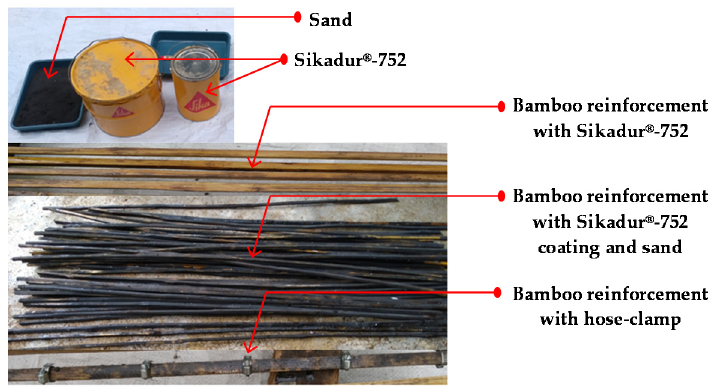
Figure 1. The materials and treatments of bamboo reinforcement.